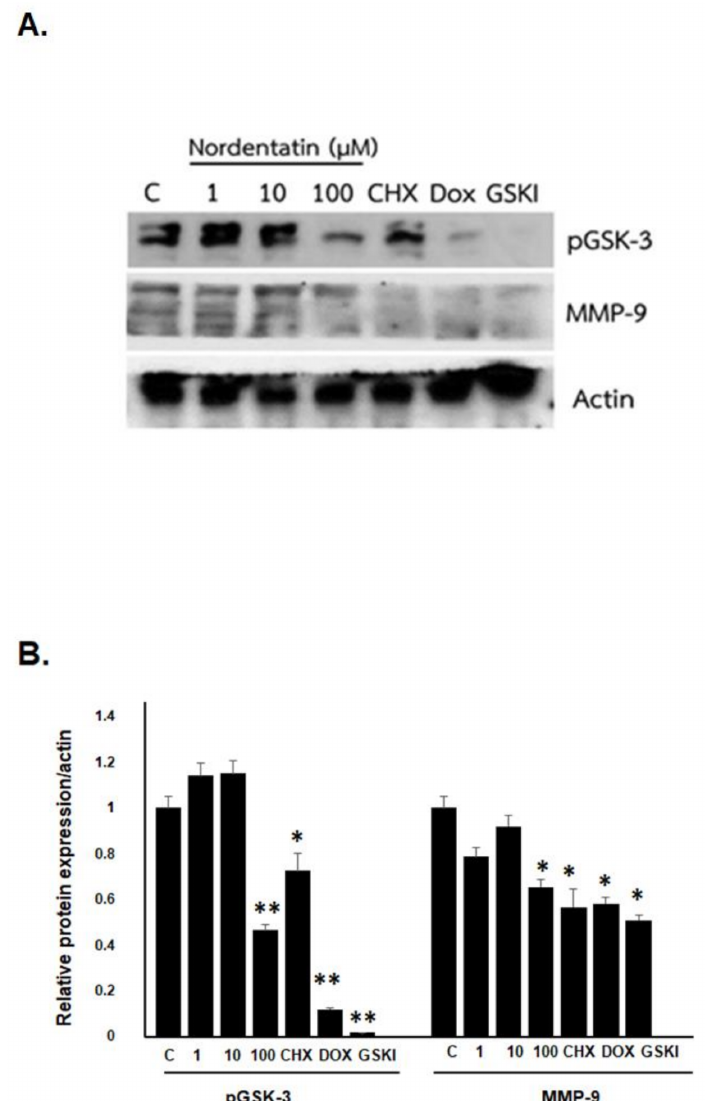
Figure 6. The effect of nordentatin on proteins involved in cell migration. ( A ) SH-SY5Y cells were treated with various concentrations of nordentatin, cycloheximide, and doxorubicin for 4 h and compared with the GSK-3 inhibitor. Cell lysates were separated by SDS–PAGE and detected by western blotting using anti-pGSK-3, MMP-9, and β -actin antibodies. ( B ) Relative phospho-GSK-3 and MMP-9 were normalized to that of β -actin. The experiments were conducted in triplicate. * p < 0.05, ** p < 0.01 versus control